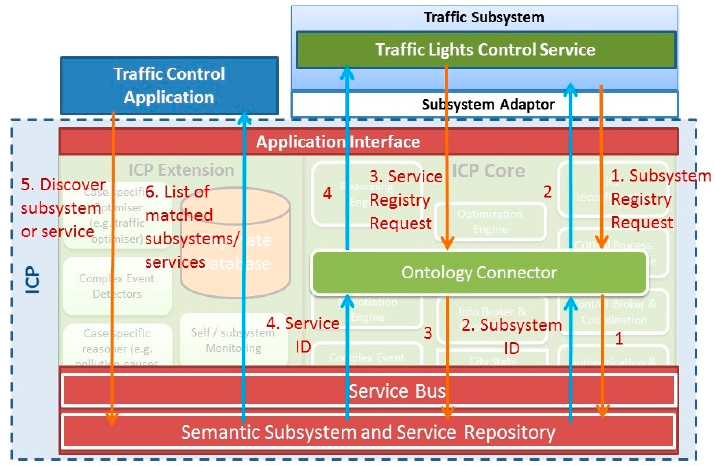
Figure 14. Example use case and registration and discovery processes.